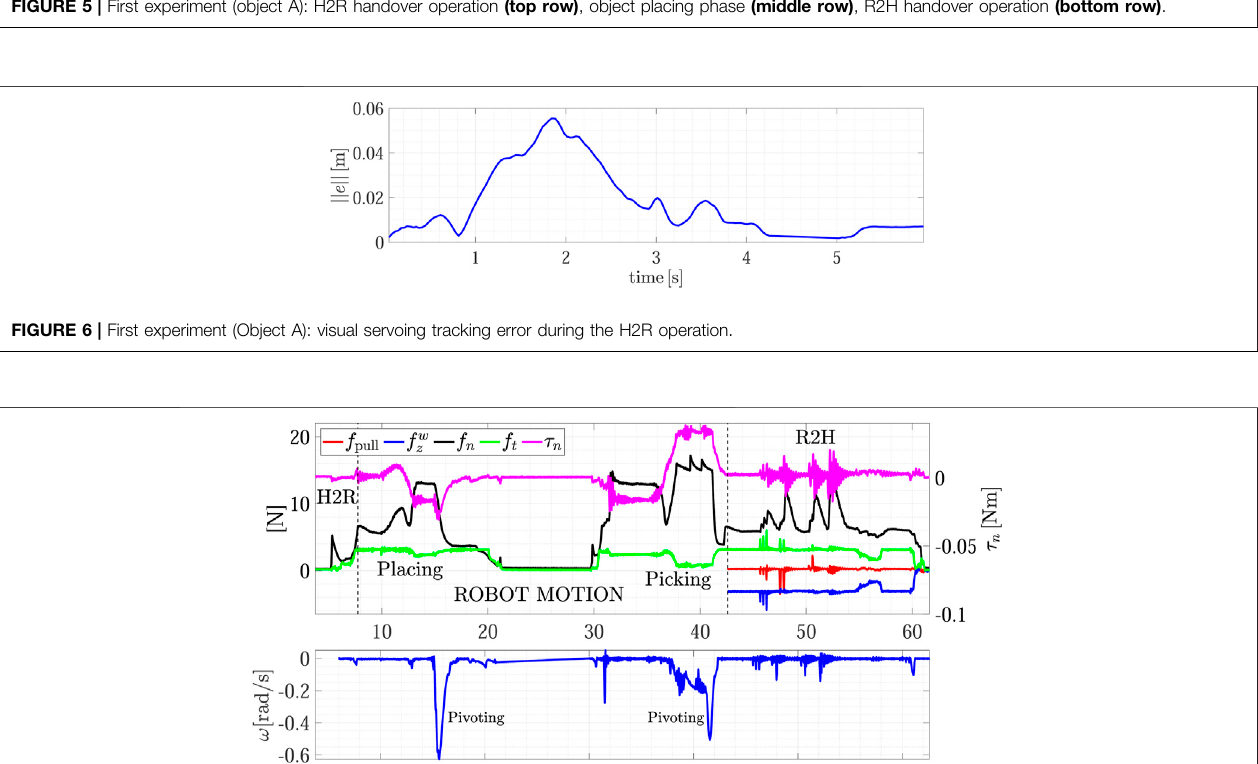
FIGURE 5 | First experiment (object A): H2R handover operation (top row) , object placing phase (middle row) , R2H handover operation (bottom row) .